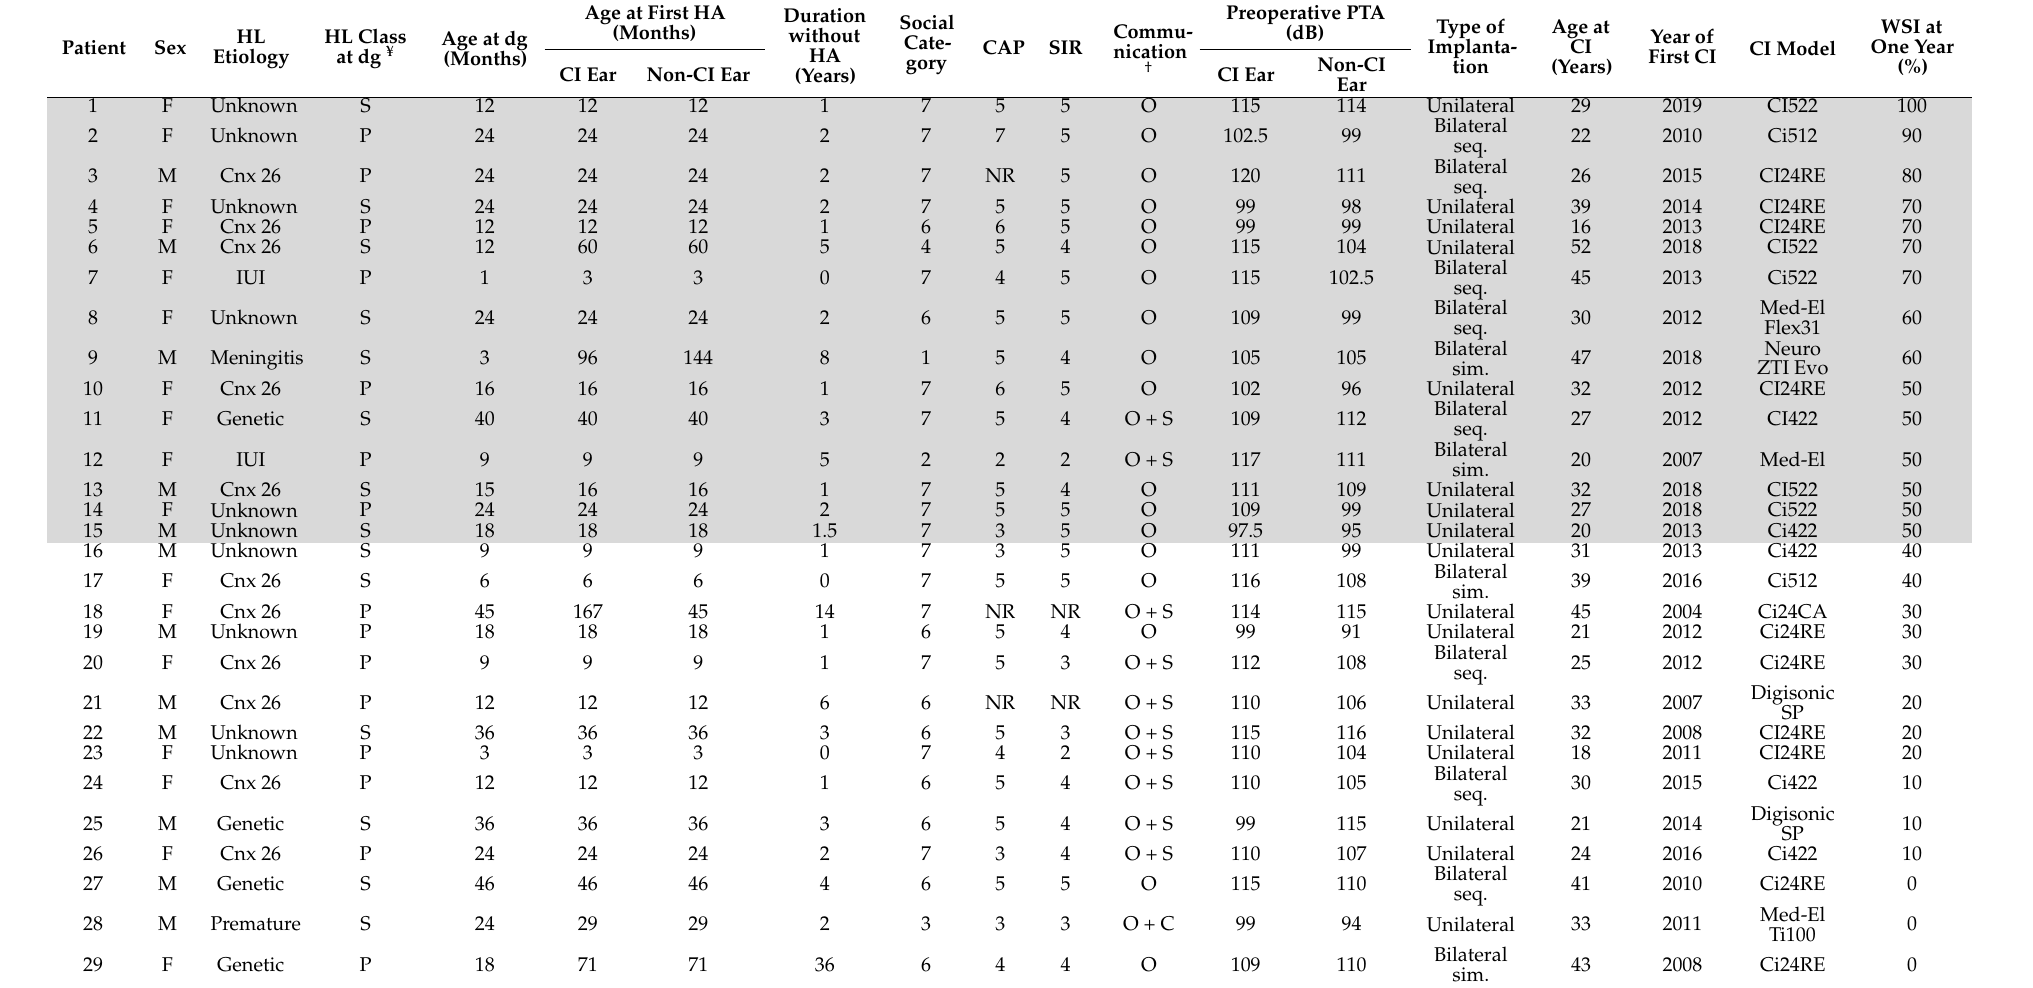
Table 1. Characteristics of implanted patients classified in function of speech intelligibility of disyllabic word score in quiet (WSI) with one cochlear implant 1 year after implantation (best or first implant outcomes are given for simultaneous or sequential bilateral implantation, respectively). Good and poor performers are patients 1 to 15 and 16 to 34,